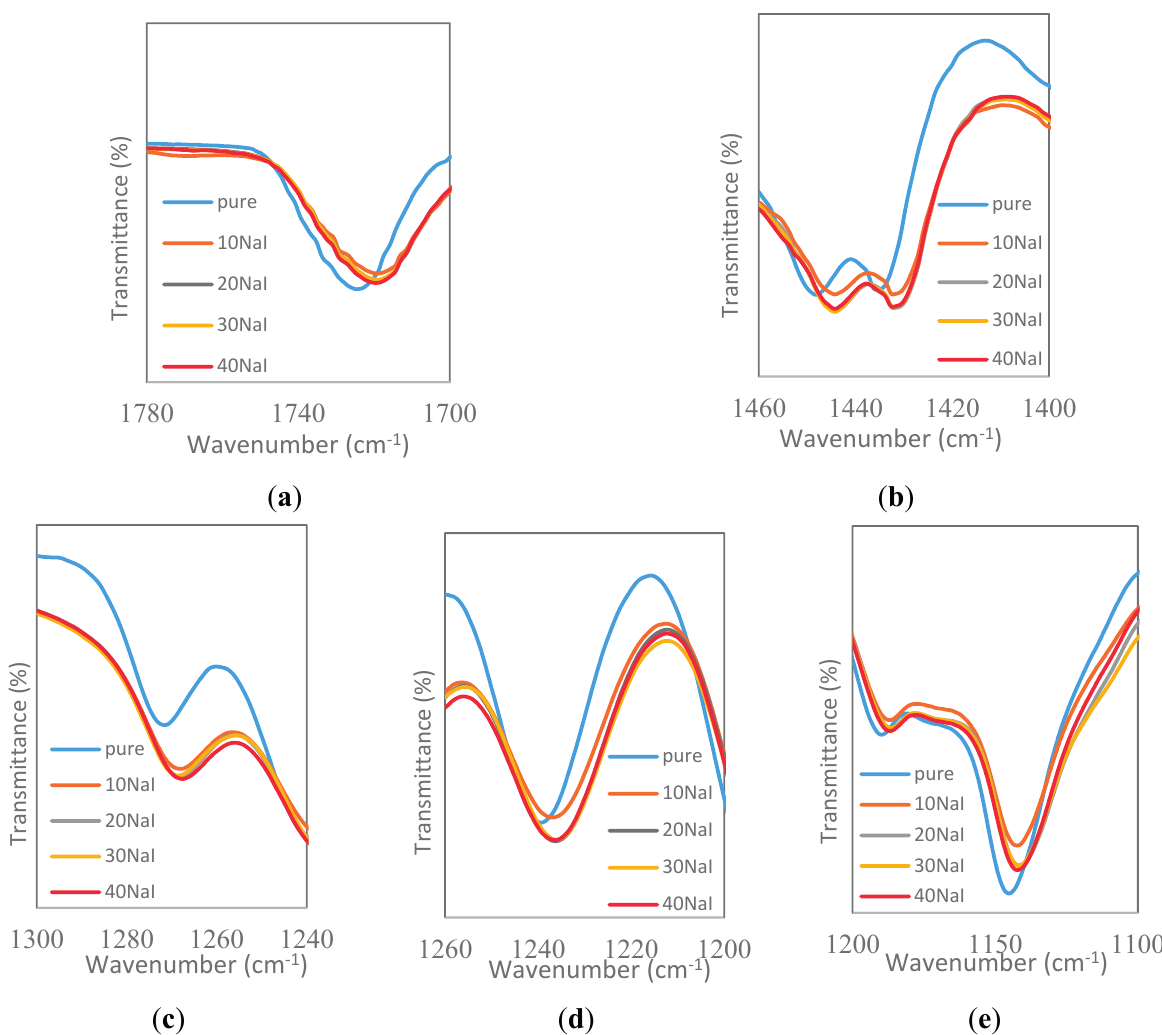
Figure 1. ( a – e ) FTIR spectra of the carbonyl, ether and methyl group of P(MMA- co -EMA) (MMA, methyl methacrylate; EMA, ethyl methacrylate) with the weight percentage ratios of NaI.